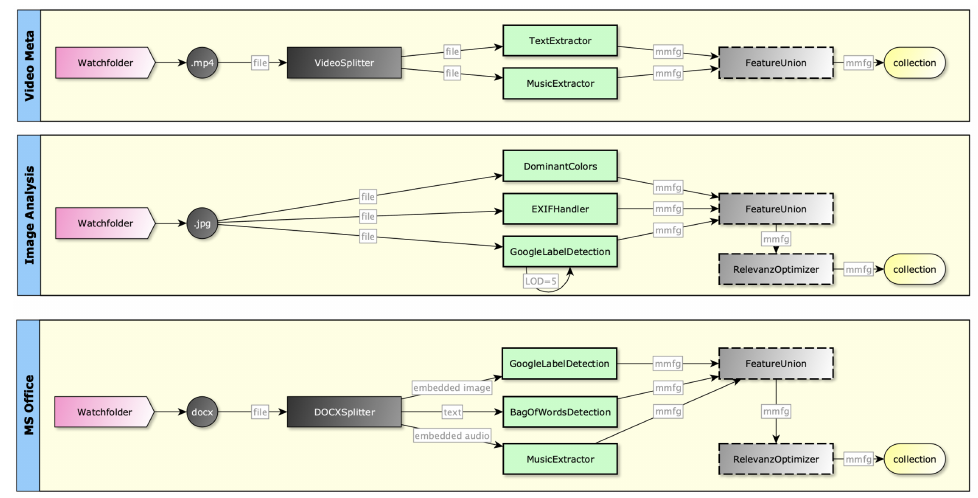
Figure 7. User-definable processing flows.